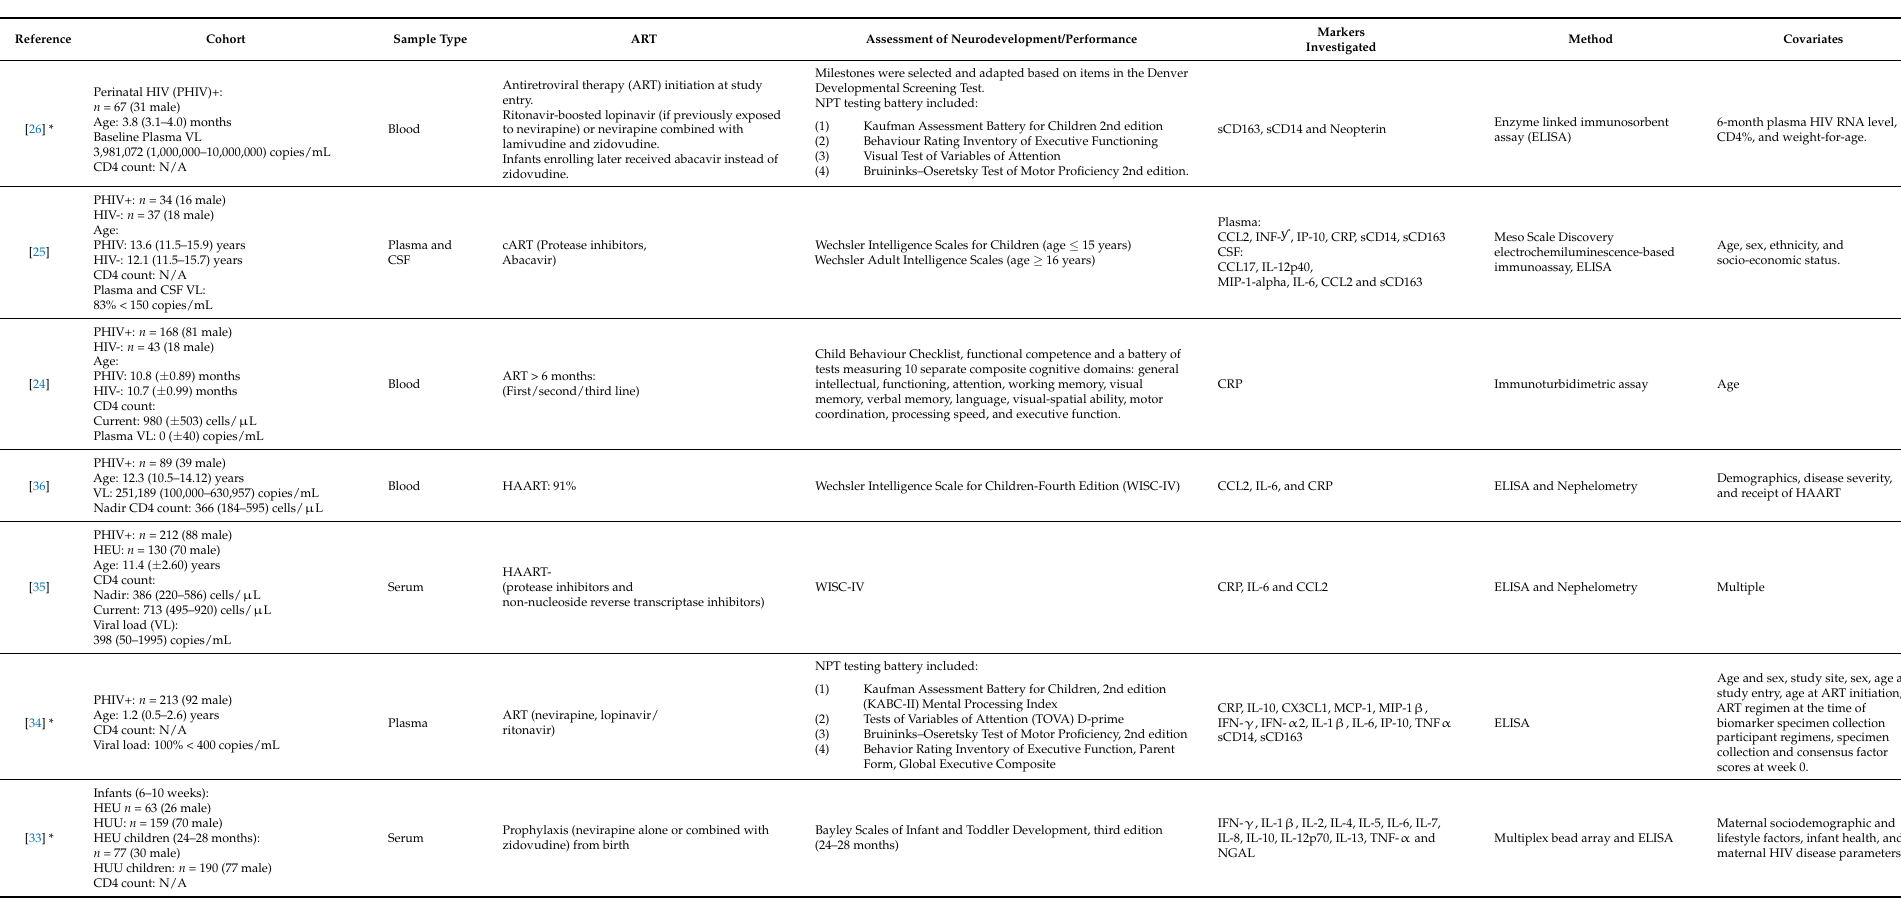
* Longitudinal study design. Abbreviations: ART (antiretroviral therapy), cART (combination antiretroviral therapy), CCL17 (thymus and activation-regulated chemokine), CCL2 (chemokine (C-C motif) ligand 2), CRP ( C-reactive protein), CSF (cerebrospinal fluid), HAART (highly active antiretroviral therapy), HEU (HIV exposed uninfected), HUU (HIV unexposed uninfected), IFN- γ (interferon gamma), IL-10 (interleukin-10), IL-12p40 (interleukin-12p40), IL-12p70 (interleukin-12p70), IL-13 (interleukin-13), IL-1 β (interleukin-1 β ), IL-2 (interleukin-2), IL-4 (interleukin-4), IL-5 (interleukin-5), IL-6 (interleukin-6), IL7 (interleukin-7), IL-8 (interleukin-8), NGAL (neutrophil gelatinase-associated lipocalin), sCD14 (soluble cluster of differentiation 14), sCD163 (soluble cluster of differentiation 163), TNF- α (tumor necrosis factor- α ) and viral load (VL). Multiple: Age, sex, race, ethnicity, primary language, caregiver education, household income, relationship of participant and caregiver, hyperlipidemia status, BMI z-score, serum lipids, body composition measures, fasting glucose and insulin, log homeostasis model assessment of insulin resistance, receipt of HAART, protease inhibitors or non-nucleoside reverse transcriptase inhibitors, CDC HIV disease class, current CD4+ cell count, current and nadir CD4+ percentage (CD4%), log viral load, and log peak viral